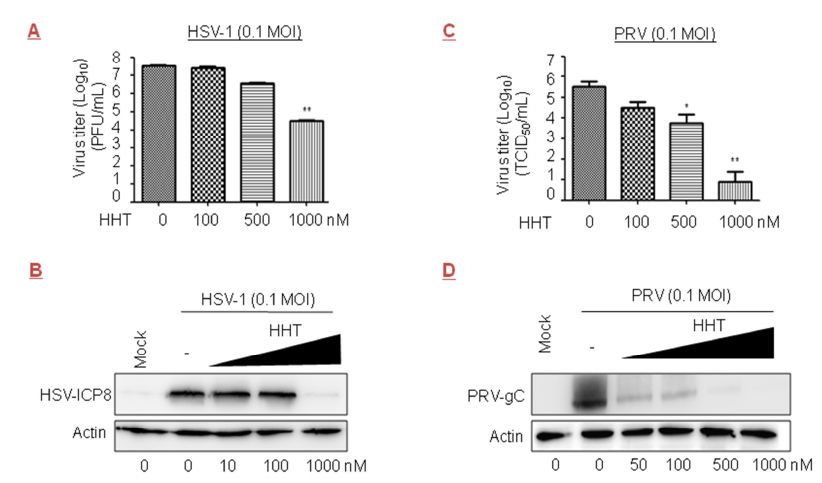
Figure 5. Inhibitory effect of HHT on herpes simplex virus type 1 (HSV-1) and pseudorabies virus (PRV) infections. ( A , B ) Antiviral activity of HHT against HSV-1. Vero cells seeded at 2.5 × 10 6 cells per well in six-well plates were infected with HSV-1 at 0.1 MOI in the presence of HHT at increasing concentrations. At 72 h.p.i., viral yields were determined by plaque assay and are presented as log 10 PFU/mL. These experiments were performed two times with three replicates in each experiment. Values represent means and SD. Statistical analysis was evaluated by one-way analysis of variance with Dunnett’s multiple-comparison test. ** p < 0.01 compared to PBS-treated group ( A ). At 48 h.p.i., cell lysates were harvested and electrophoretically separated proteins were analyzed by immunoblotting with antibodies to viral protein HSV-ICP8 and actin ( B ). ( C , D ) Antiviral activity of HHT against PRV. Vero cells were infected with PRV at 0.1 MOI in the presence of HHT at increasing concentrations as indicated. At 48 h.p.i., viral yields in the medium were determined by TCID 50 , and assessed as indicated in Figure 3A. * p < 0.05; ** p < 0.01 compared to PBS-treated group ( C ). At 36 h.p.i., cell lysates were harvested and electrophoretically separated proteins were analyzed by immunoblotting with antibodies to viral protein PRV-gC and actin ( D